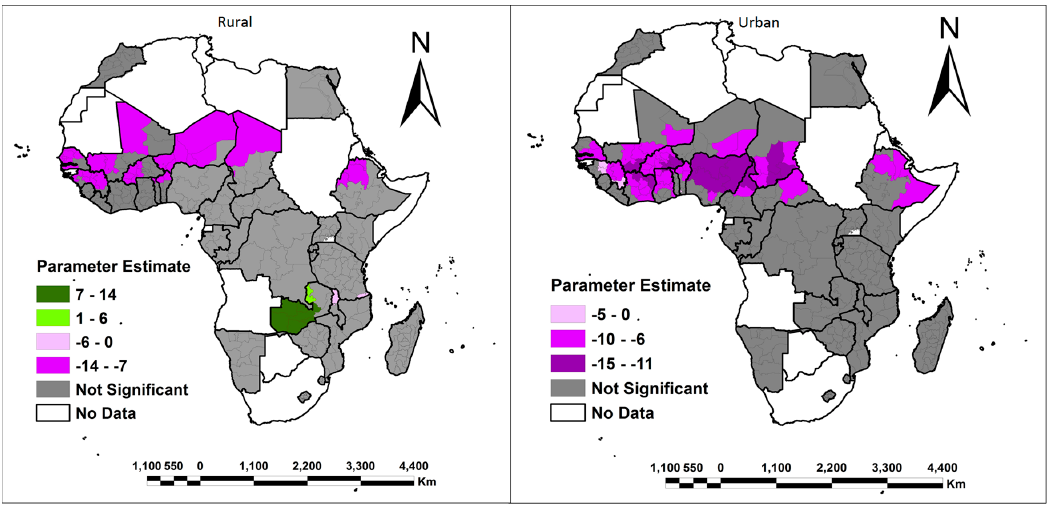
Figure 16. Spatial distribution and significance of place of residence on women’s access to family land.